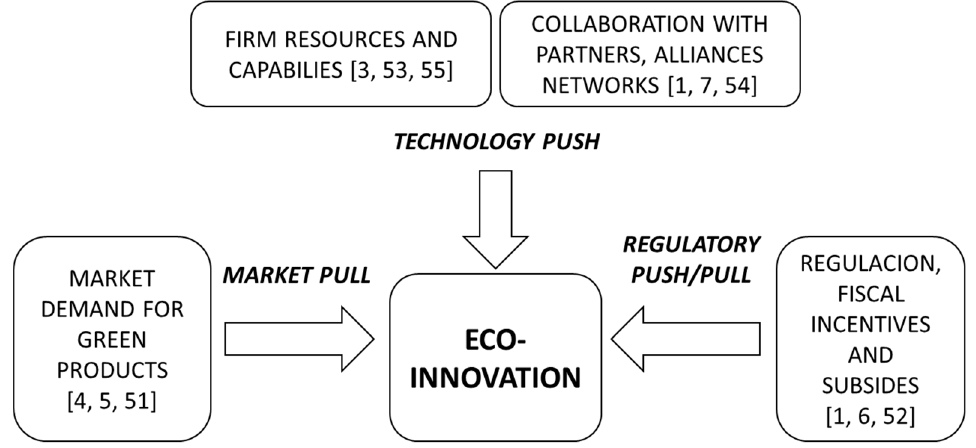
Figure 1. Drivers of eco-innovation. Adapted from Triguero et al. [16].